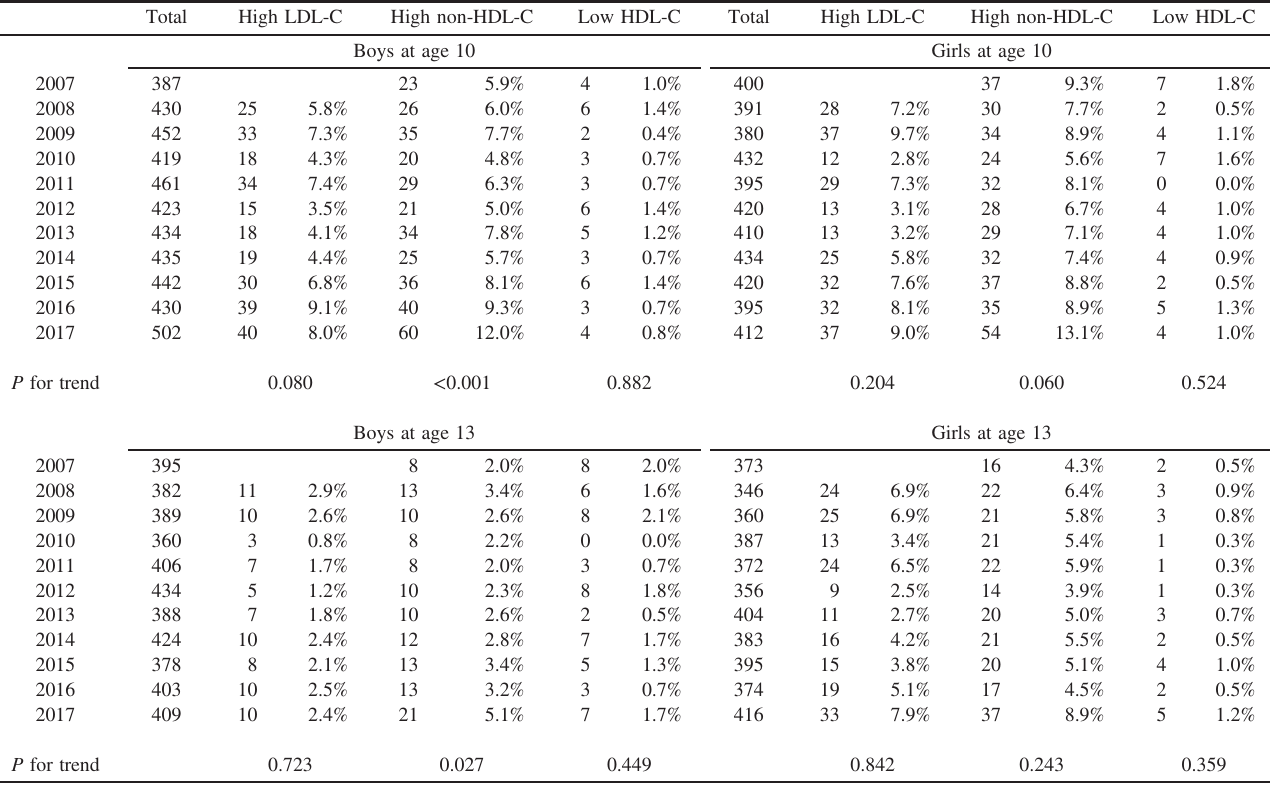
Table 3. Secular trends in children with dyslipidemia (numbers and proportions)